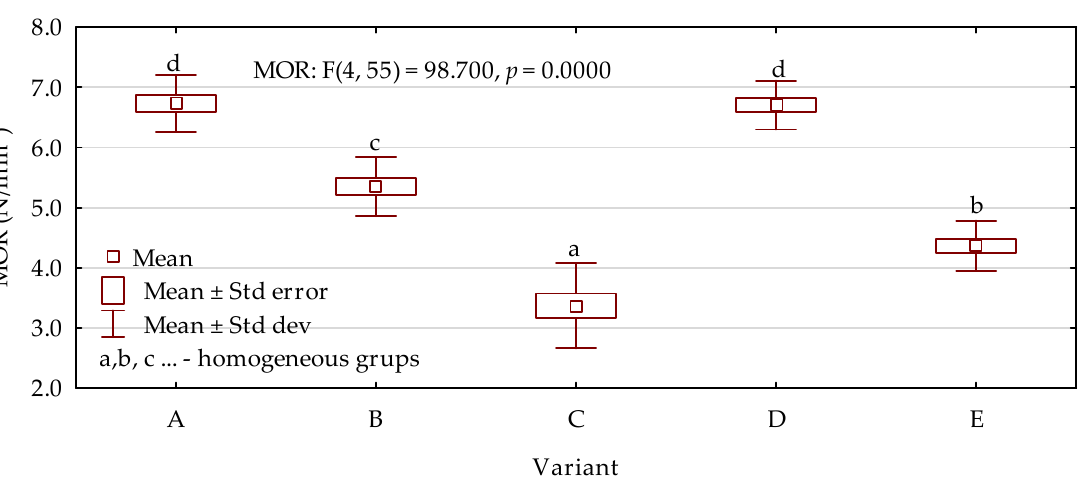
Figure 6. Modulus of rupture results depending on the board variant (letters A–E mark variants of the boards).